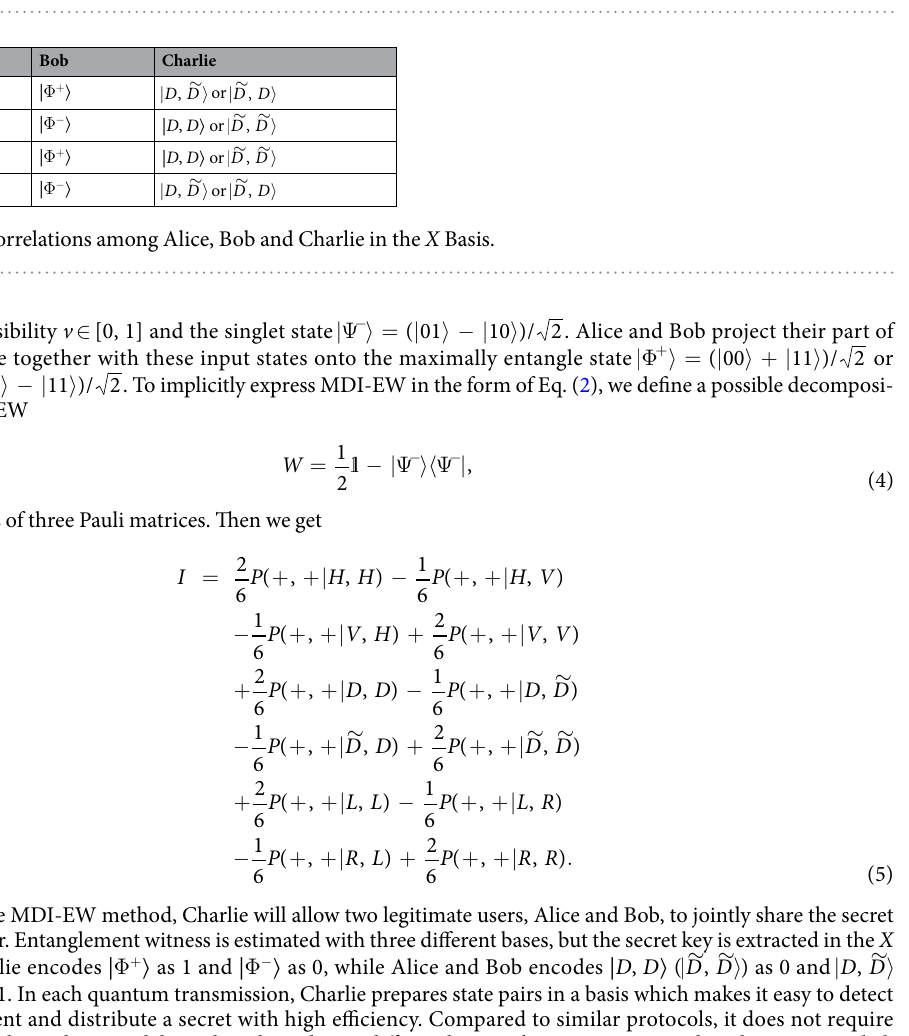
Figure 1. The schematics of the experimental setup for the DDI-QSS. Charlie prepare single-photon state pairs | τ s , ω t 〉 as the signal states. The Werner state preparation setup consist of photon pairs generation by spontaneous parametric down conversion (SPDC). The experimental setup for Bell analysers consist of polarizing beam splitter (PBS) and half-wave plate (HWP) at 22.5°. All the photons are detected by sing-photon detector D.